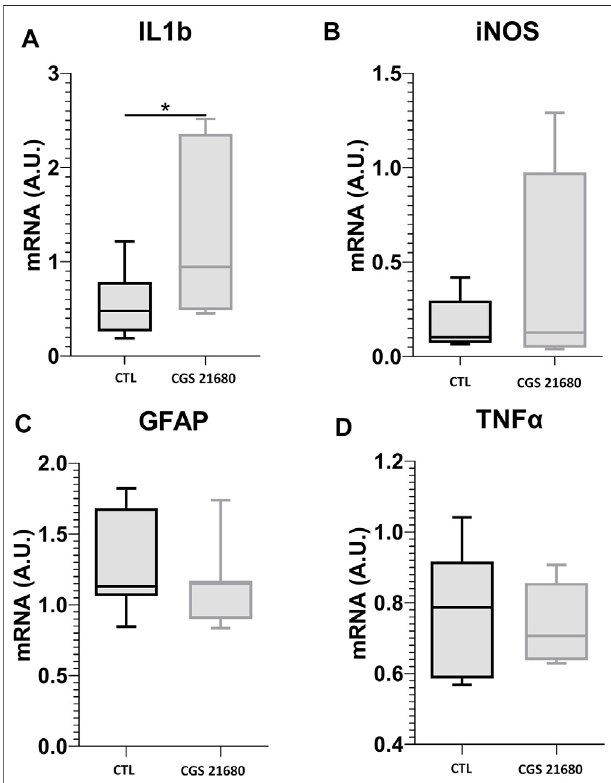
FIGURE 4 | qRT-PCR for IL-1 β (A) , iNOS (B) , GFAP (C) , and TNF- α (D) mRNAs in retinas from CGS21680 and their respective CTL. Boxes represent 25 and 75 percentiles, whiskers represent minimum and maximum values, and transverse lines represent medians (Student ’ s t -test, * p < 0.05).